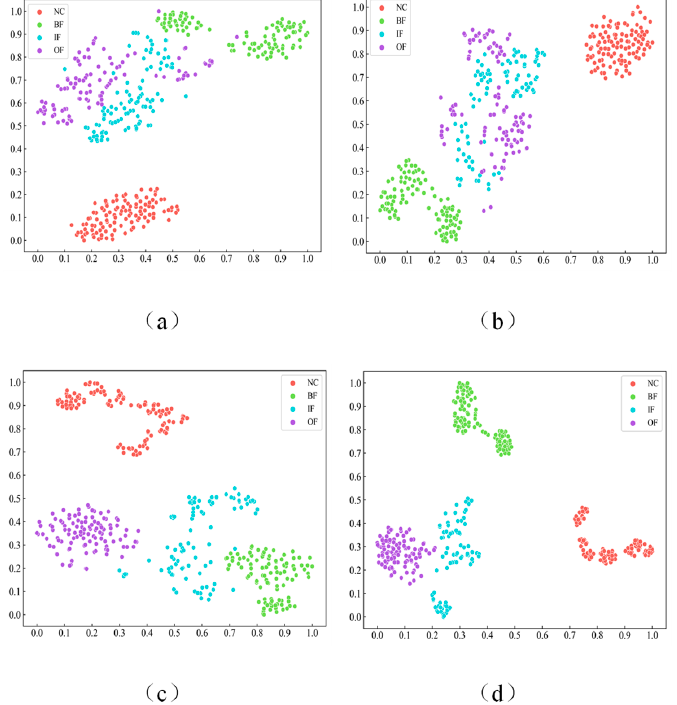
Figure 15. Visualization of engineering data with different methods for t-SNE. ( a – d ) corresponding to the VGGNet, Conv5, ProtoNet-10 shot, and our method-10 shot.